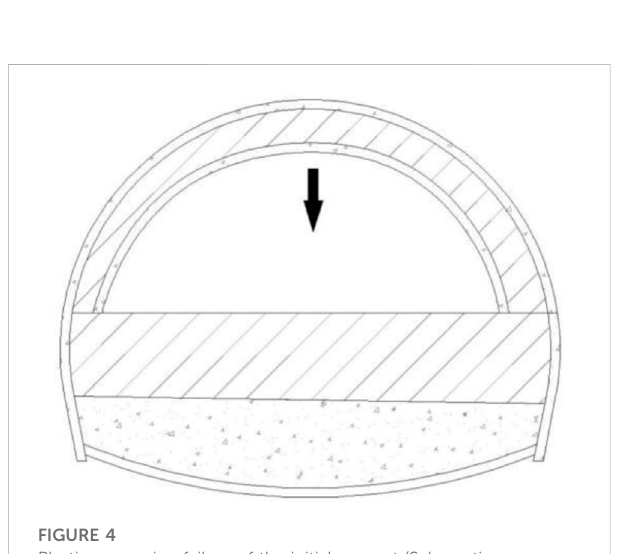
FIGURE 4 Plastic-squeezing failure of the initial support (Schematic diagram).